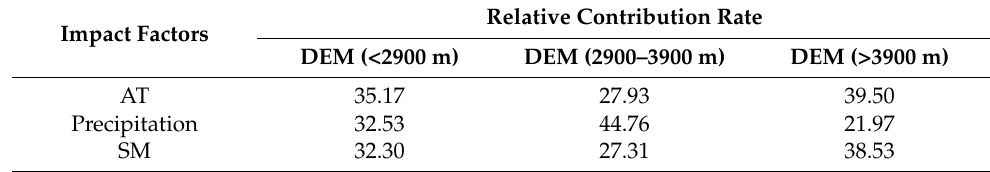
Table 4. Relative contribution rate of environmental factors of NDVI dynamics